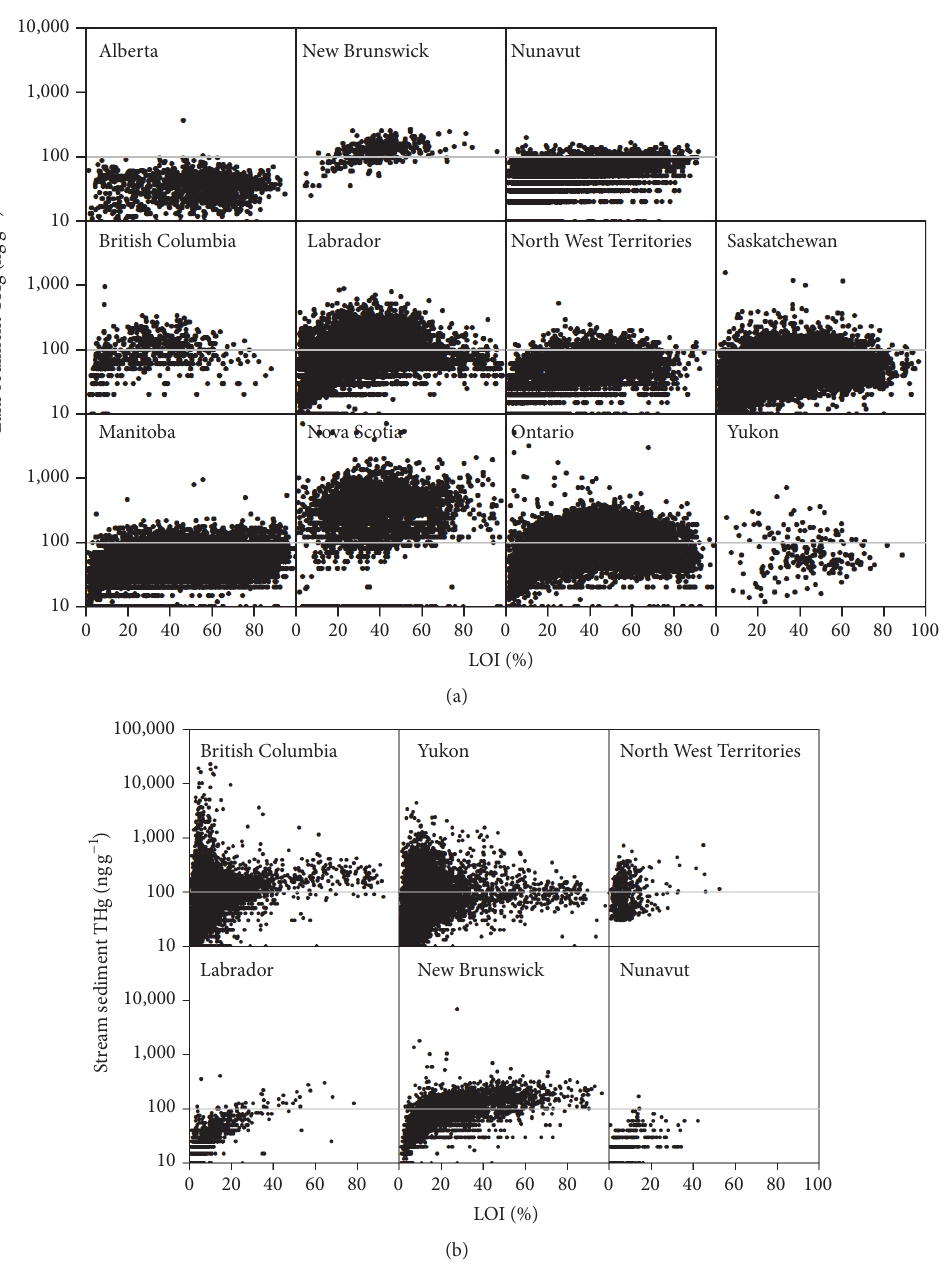
Figure 3: Scatterplots of lake (a) and stream (b) sediment THg (ngg −1 , log 10 scale) versus LOI (%) by provinces/territories across Canada.